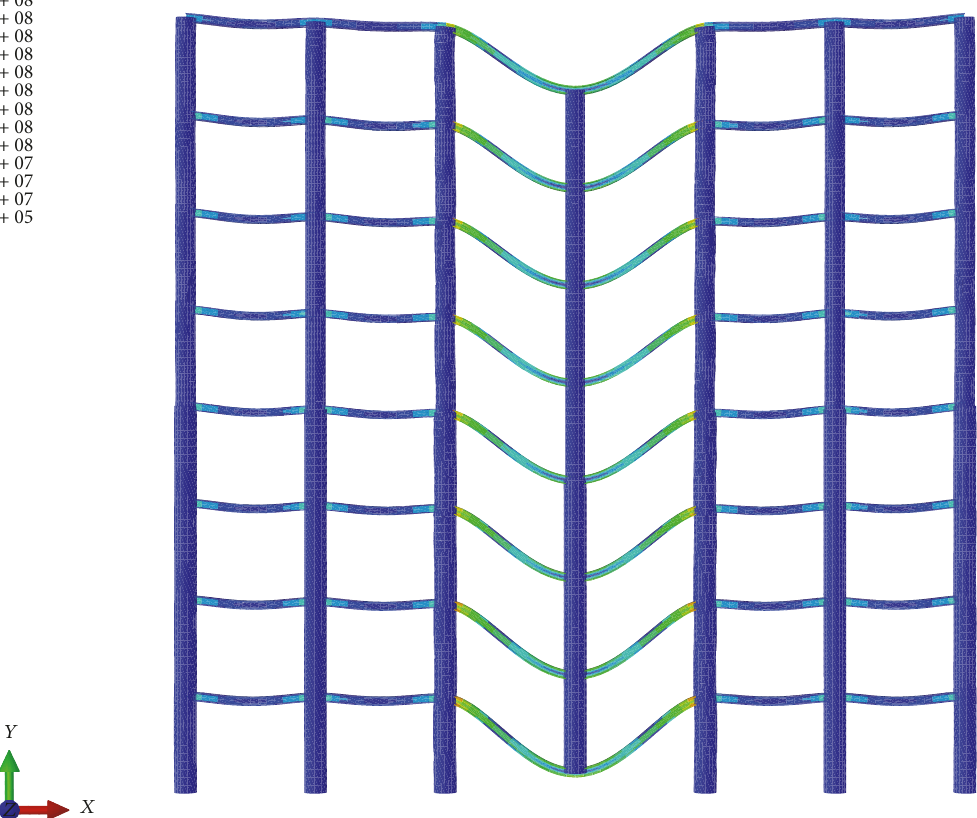
Figure 11: Deformation cloud diagram of the hybrid frame after the failure of the bottom middle column.